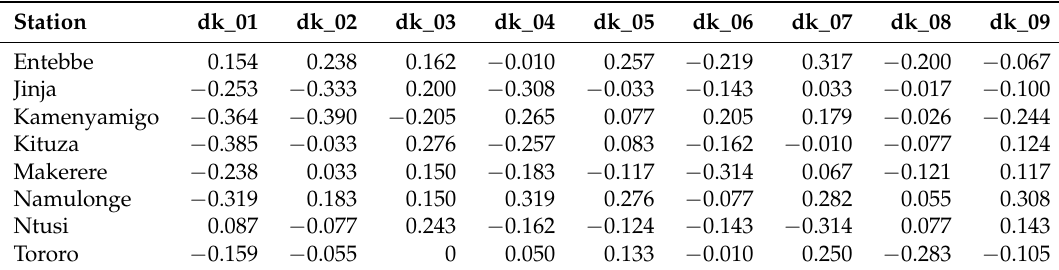
Table 6. MK results for dekadal rain